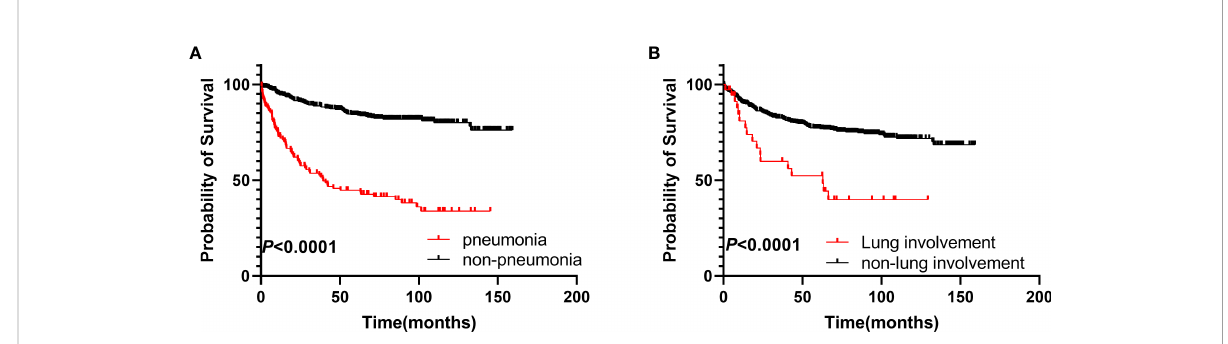
FIGURE 1 Survival analysis of the two groups. (A) OS of patients in the pneumonia group compared to those in the non-pneumonia group. (B) OS of patients with pulmonary involvement compared to those without pulmonary involvement. OS, overall